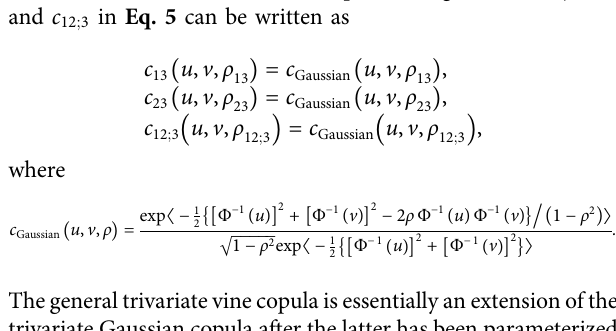
Frontiers in Applied Mathematics and Statistics |